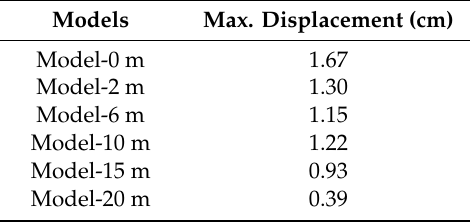
Figure 19. Top displacement time histories. Table 6. Maximum top displacements.